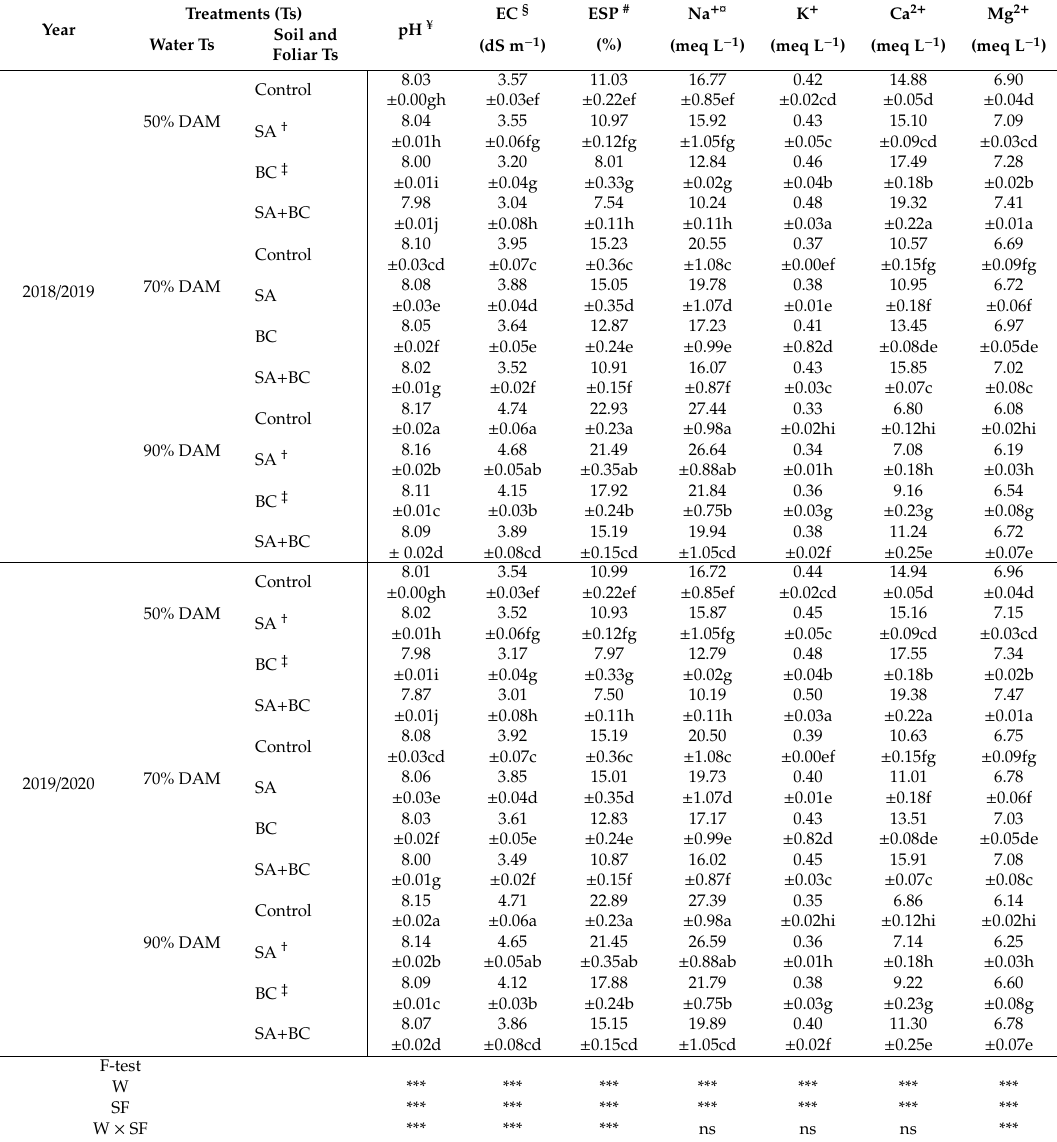
Table 1. Soil chemical properties at the harvest of wheat plants irrigated with (50%, 70%, and 90% depletion of available soil moisture (DAM)) in saline sodic soil treated by salicylic acid and biochar during two growing